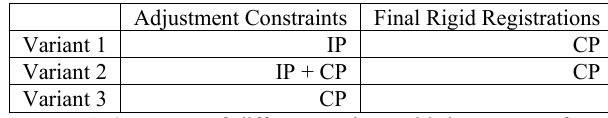
Table 1. Summary of different settings with image pose from the directed georeferencing (IP) and control points